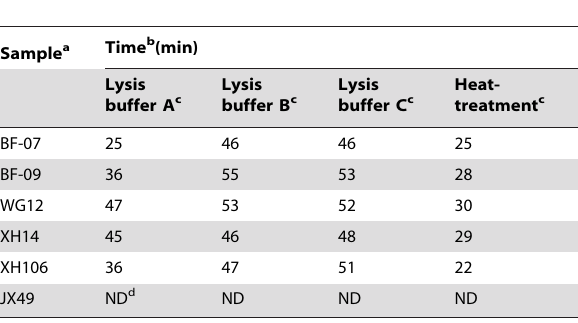
Table 3. Preliminary study of sample treatment for EV71 detection by direct RT-LAMP using various lysis buffers and